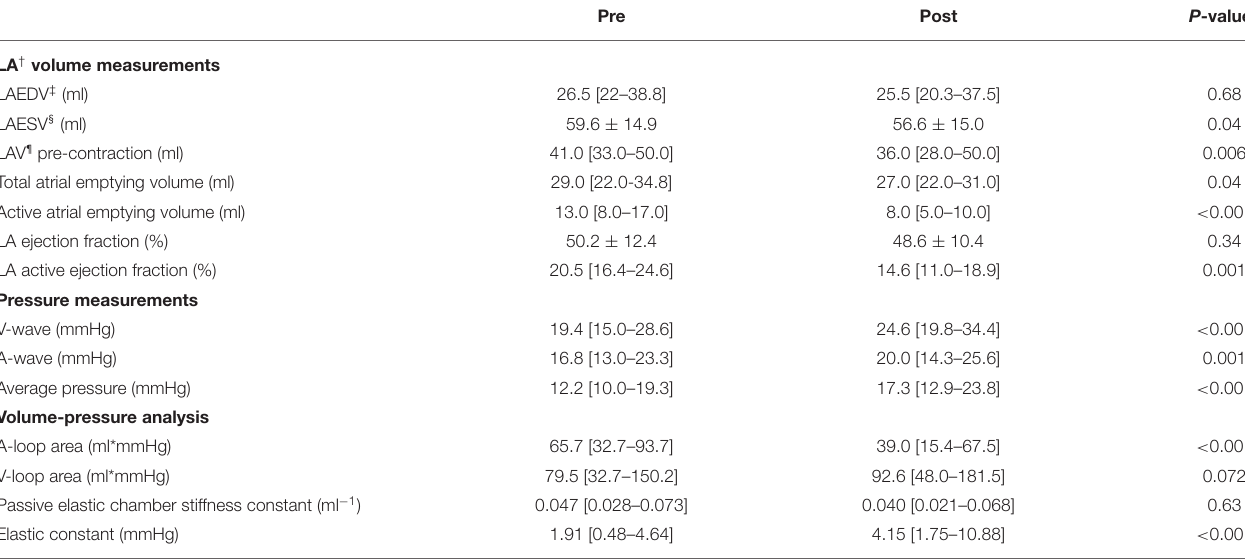
TABLE 2 | Procedure-induced changes in echocardiographic, haemodynamic, and volume-pressure